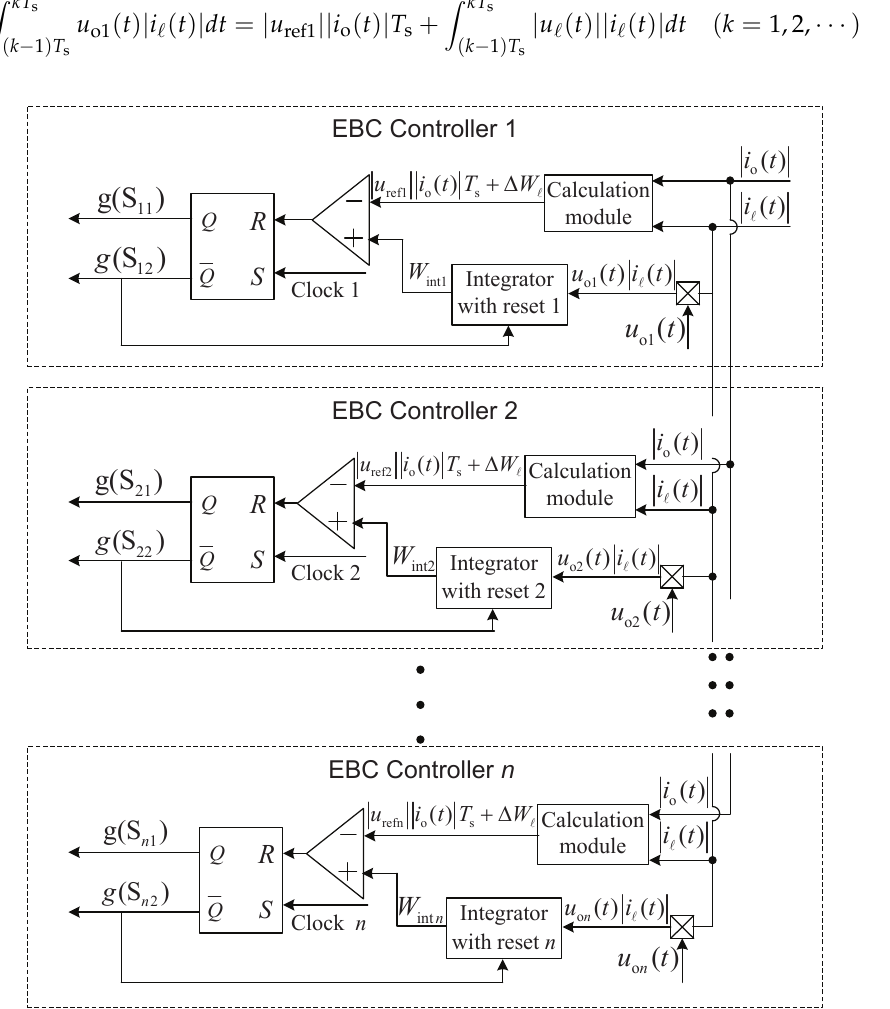
Figure 3. The structure of the CPS EBC method for the topology leaving out the details of the second